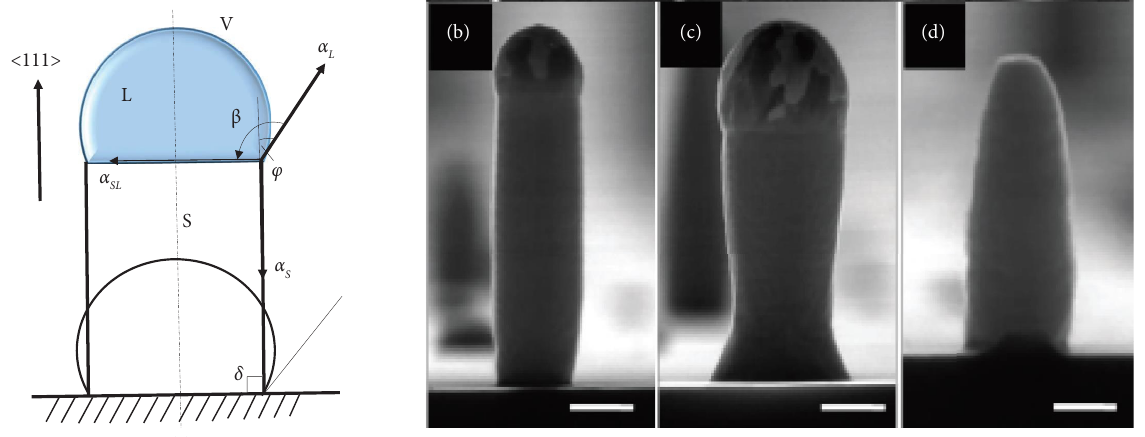
Figure 14: Scheme of NW growth without the formation of a cone-shaped base (a) and SEM images of Si NWs grown on a Si (111) substrate with an Au catalyst and diferent morphologies [24] (b) without a cone-shaped base with a constant diameter, (c) with a cone-shaped pedestal at the base and a diameter increasing towards the apex, and (d) with a straight base and a diameter decreasing in height. Droplets (b) and (d) continuously received additional Au, which compensated for the narrowing of the stem at the base. Scale 100nm.